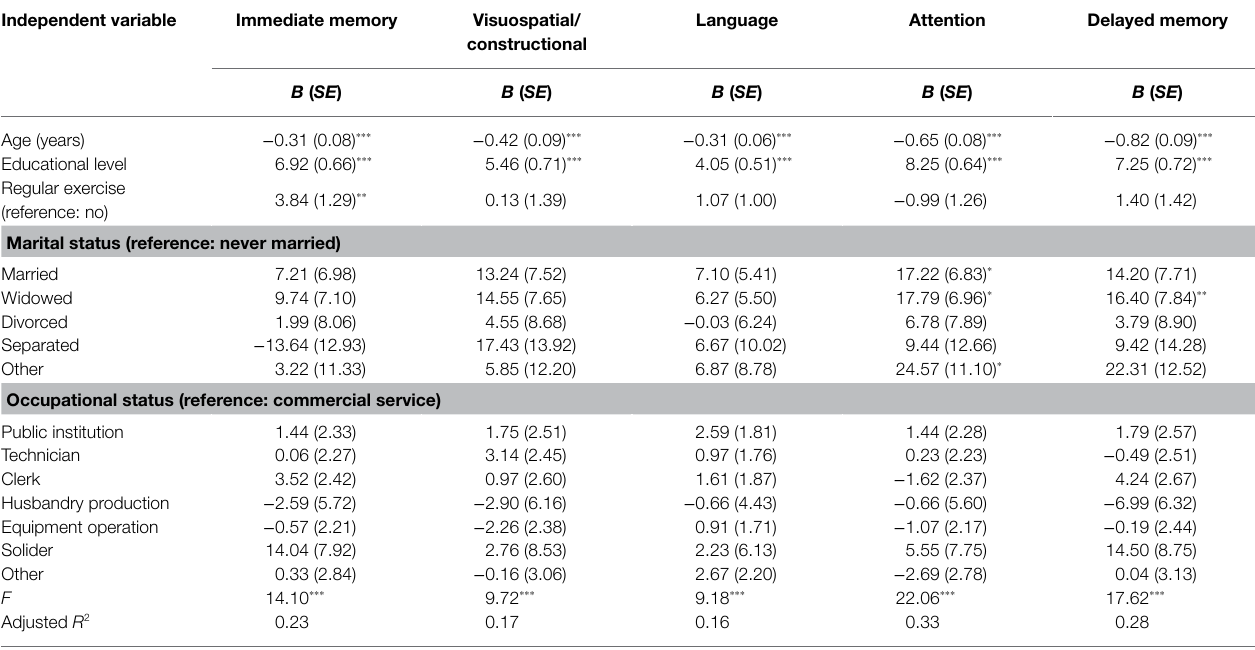
TABLE 5 | Multivariate linear regression of the association between the RBANS index and factors. Independent variable Immediate memory Visuospatial/ Language Attention Delayed constructional